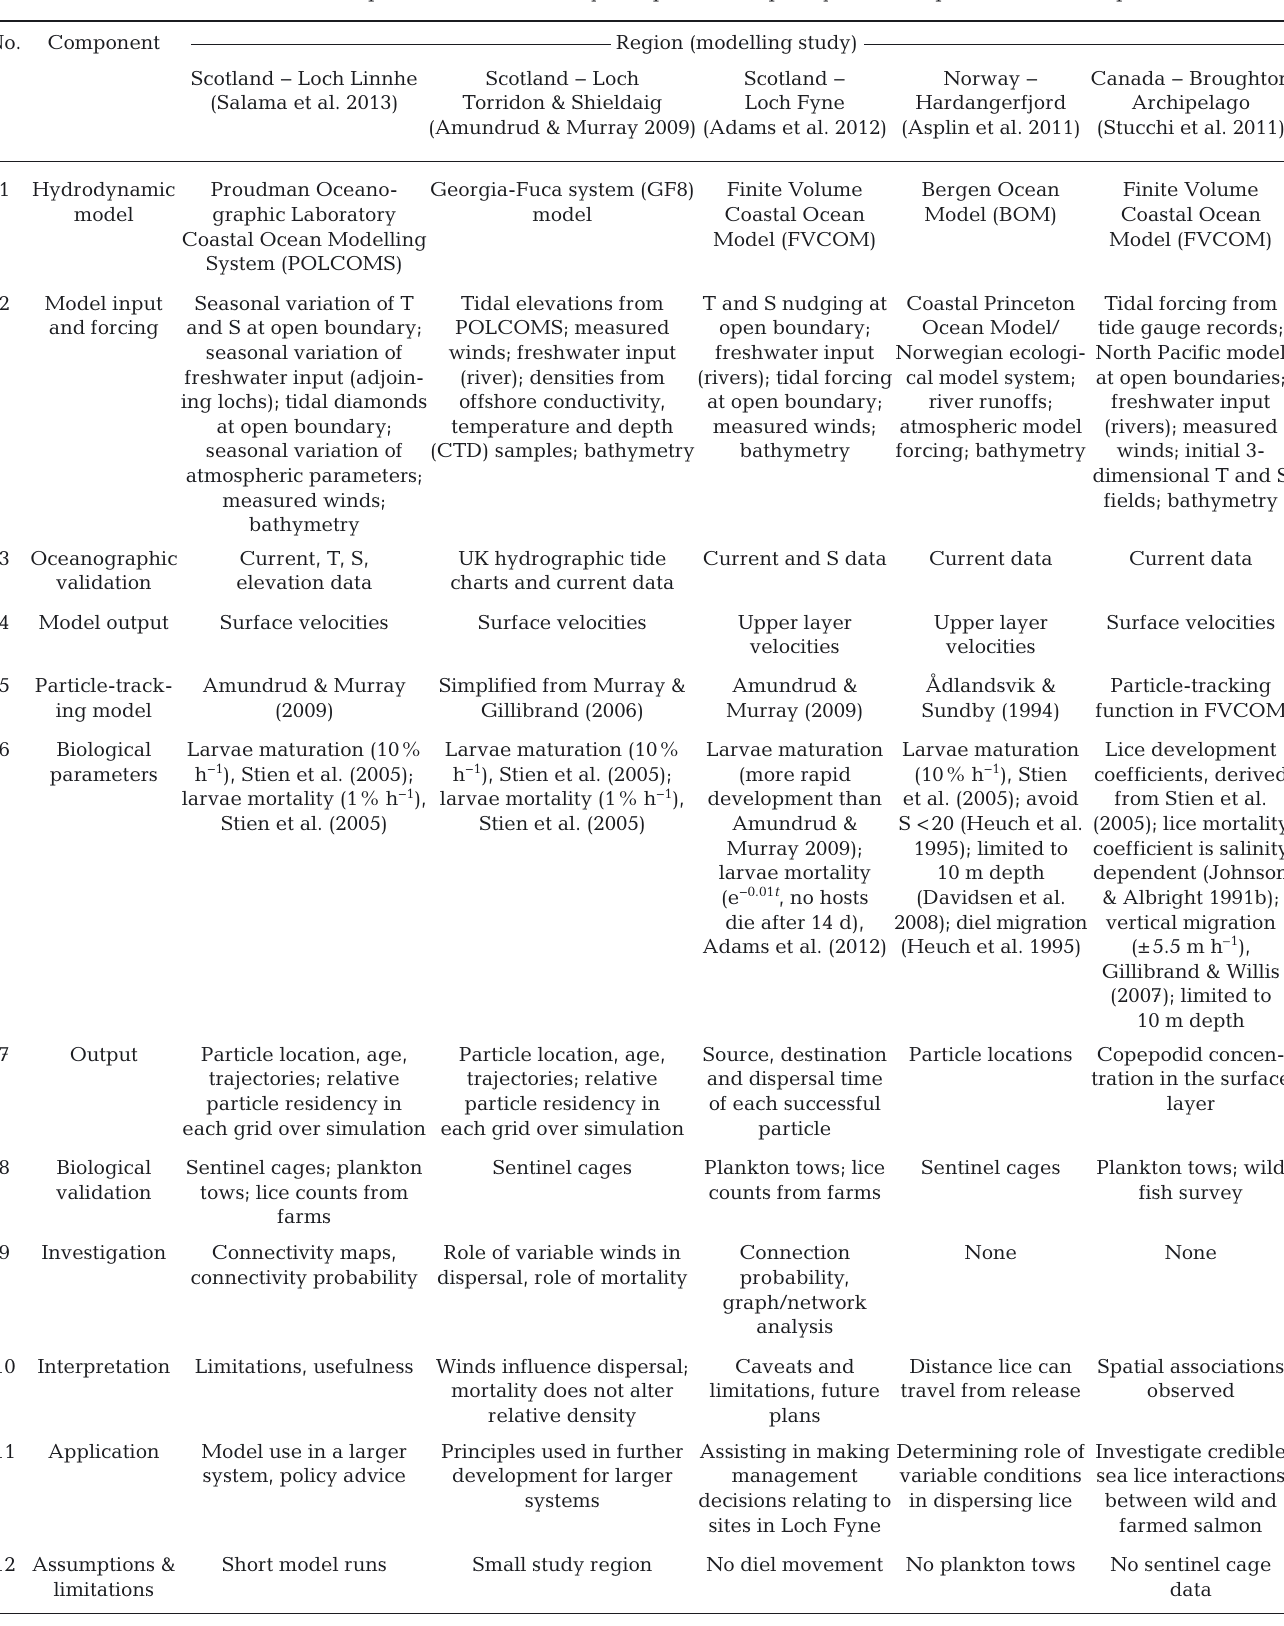
Table 1. Summary of the components highlighted in Fig. 1 and how several studies have addressed such principles. Note that the assump- tions and limitations are limited to 1 example, due to the vast array of implicit and explicitly described possibilities. T: temperature, S: salinity